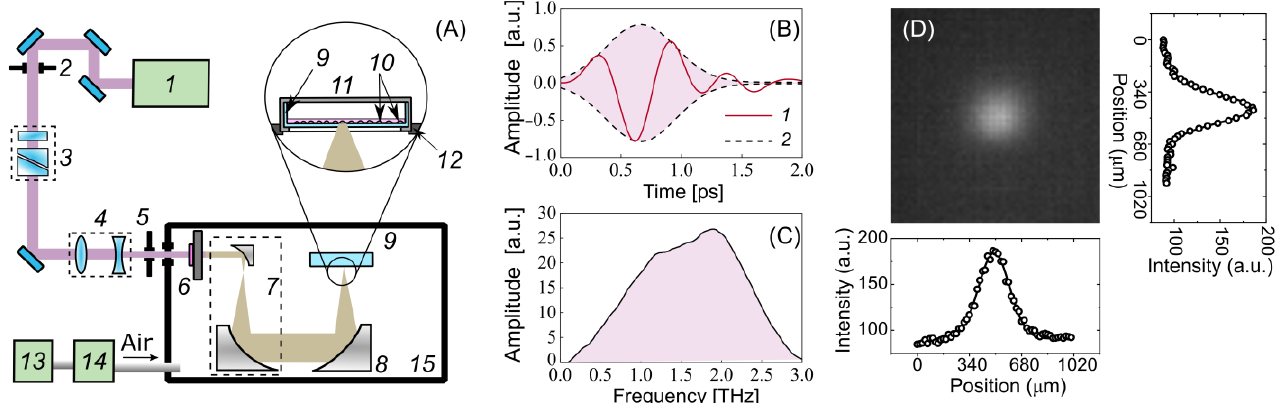
Figure 5. Experimental setup for cell irradiation. ( A ) Schematic: 1—femtosecond laser, 2, 5—iris diaphragm, 3—polarization attenuator, 4—lens telescope, 6—OH1 crystal with a filter, 7—mirror telescope, 8—focusing mirror, 9—Petri dish, 10—cells, 11—heated plate and cover, 12—3-axis